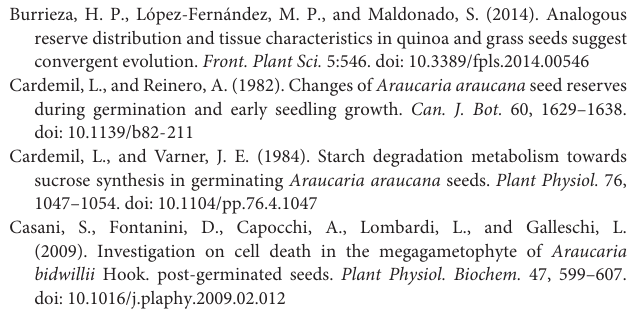
FIGURE S1 | Amido black staining at 0, 14, and 42 DAG in the megagametophyte sections. Amido black stains total proteins. They were visible at 0 DAG. At 14 and 42 DAG, vacuoles shown that storage proteins are consumed early. In all sections, nuclear proteins were also dyed. Abbreviations: cc , crushed cells; v , vacuole; cw , cell wall; am, amyloplasts. Scale bar = 50 µ m. Each image is a representative result of observation of at least 30 semi-thin sections of a different megagametophyte tissue at different DAG. FIGURE S2 | Lugol staining at 0, 14, and 42 DAG in the megagametophyte sections. Starch was progressively consumed during germination. Starch